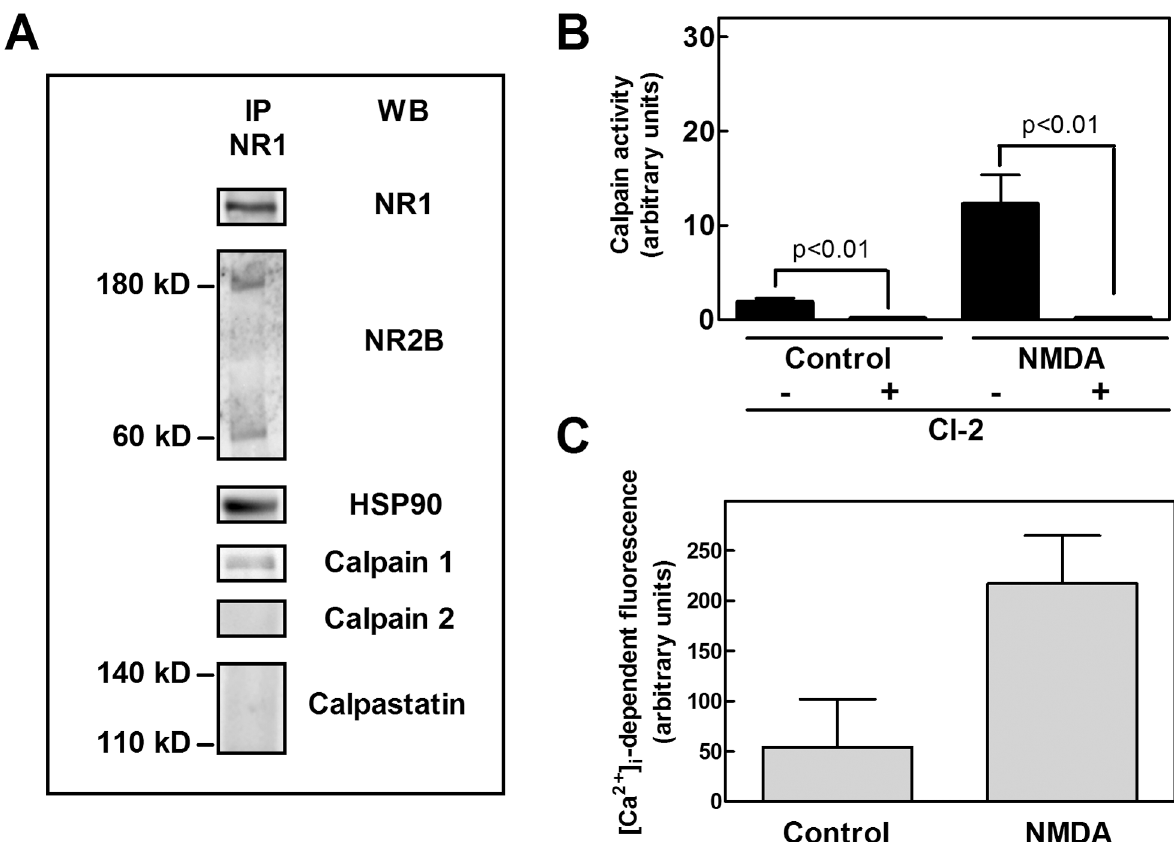
Fig 1. NMDAR cluster and calpain activity in SKNBE cells. (A) SKNBE cells were lysed to perform immunoprecipitation with 1 μ g of anti-NR1 antibody. The immunoprecipitated material (IP NR-1) was analyzed by immunoblotting (WB) to detect the indicated proteins. Each immunoblot is representative of four different experiments. (B) SKNBE cells (2 × 10 5 ) were incubated in 100 μ L of isotonic HEPES buffer containing 50 μ M t-Boc-Leu-Met-CMAC fluorogenic calpain substrate (see Methods). Cells were then washed and suspended in 100 μ L of HEPES buffer containing 10 μ M glycine and 1 mM CaCl 2 . Calpain activity was measured in the absence (Control) or presence (NMDA) of 100 μ M NMDA. Calpain activity was also measured in cells pre-incubated for 30 minutes with 1 μ M Calpain inhibitor 2 (CI-2). The values reported are the arithmetical mean ± SEM of four different experiments, and p values were calculated according to t -test. (C) Calcium Green ™ -loaded cells were exposed to the indicated stimuli. Data are means ± SEM from two independent experiments in duplicate.